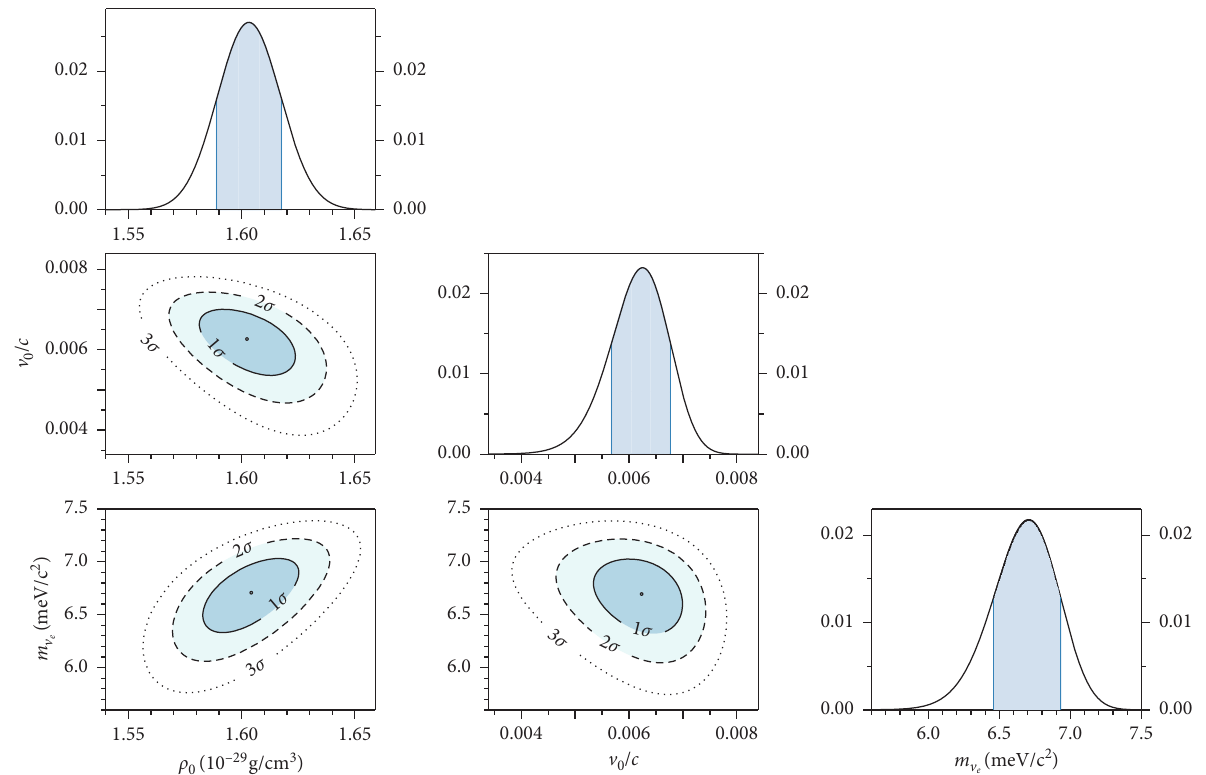
Figure 5: Likelihood contours for the central density ( ρ effective electron neutrino mass ( m ] m � 6 . 70 ± 0 . 23 meV/c 2 . However, the systematic uncertainty associated with model assumptions likely dominates over the statistical ] e